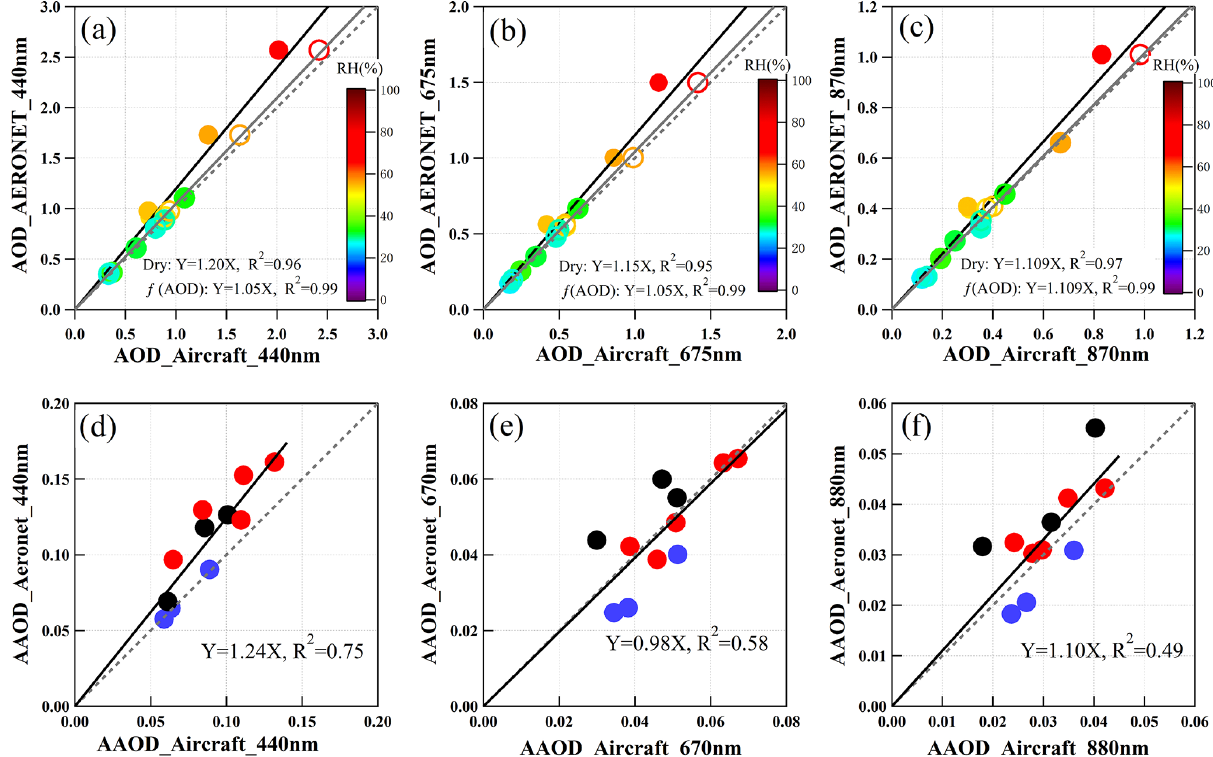
Figure 5. Comparison between AERONET and aircraft in situ constrained AOD and AAOD: (a) – (c) the comparison of AOD at 440, 675 and 870nm, with a colour gradient representing different levels of RH. The solid and open markers denote the dry and hygroscopicity- corrected conditions. (d) – (f) Comparison of AAOD at 440, 670 and 880nm. The blue, black and red circles represent the CPs, TPs and HPs,